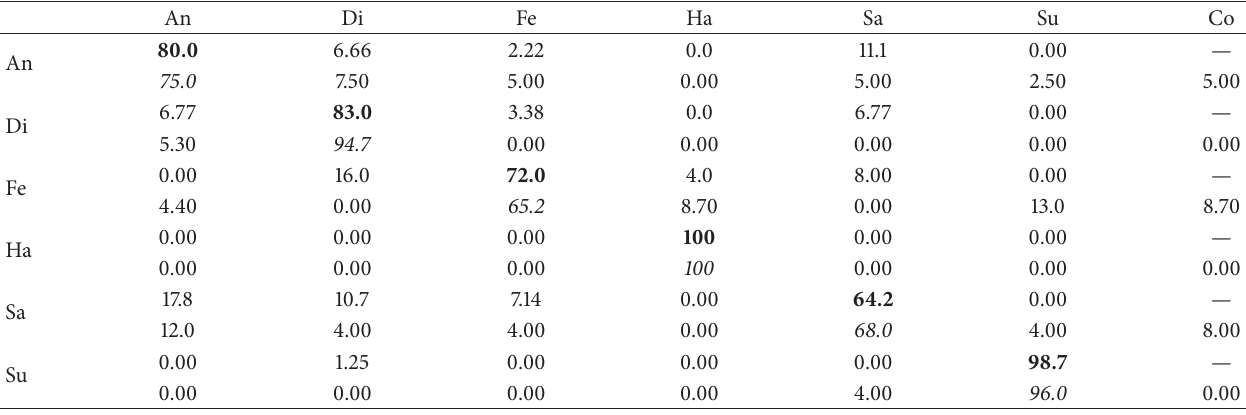
Table 2: Confusion matrix of human facial expression recognition for the CK+ database. The first row in each expression represents our results (with SVM classifier). The other row shows the results of Lucey et al., as reported in [13].